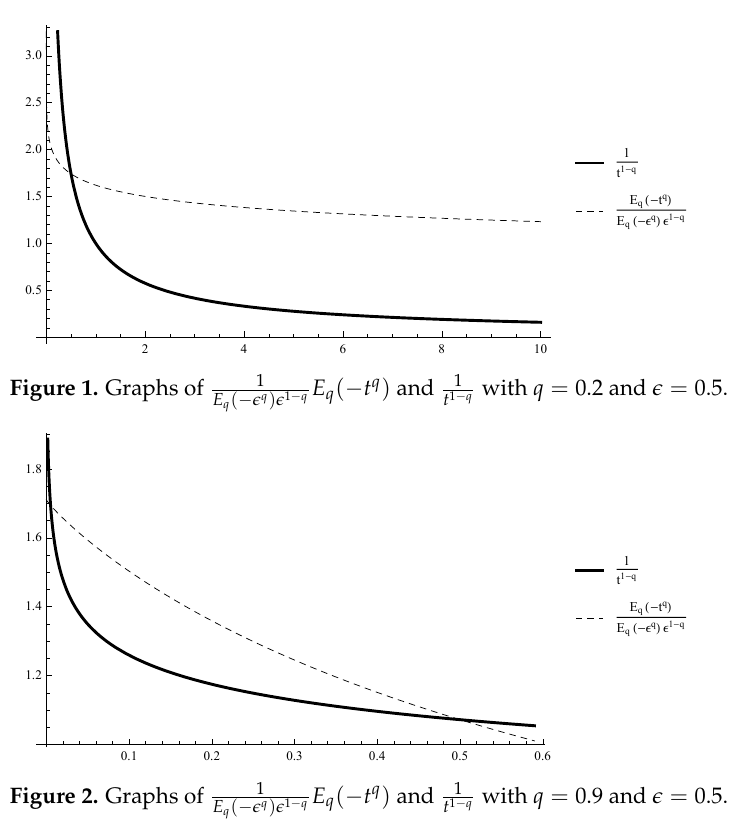
Figure 1. Graphs of